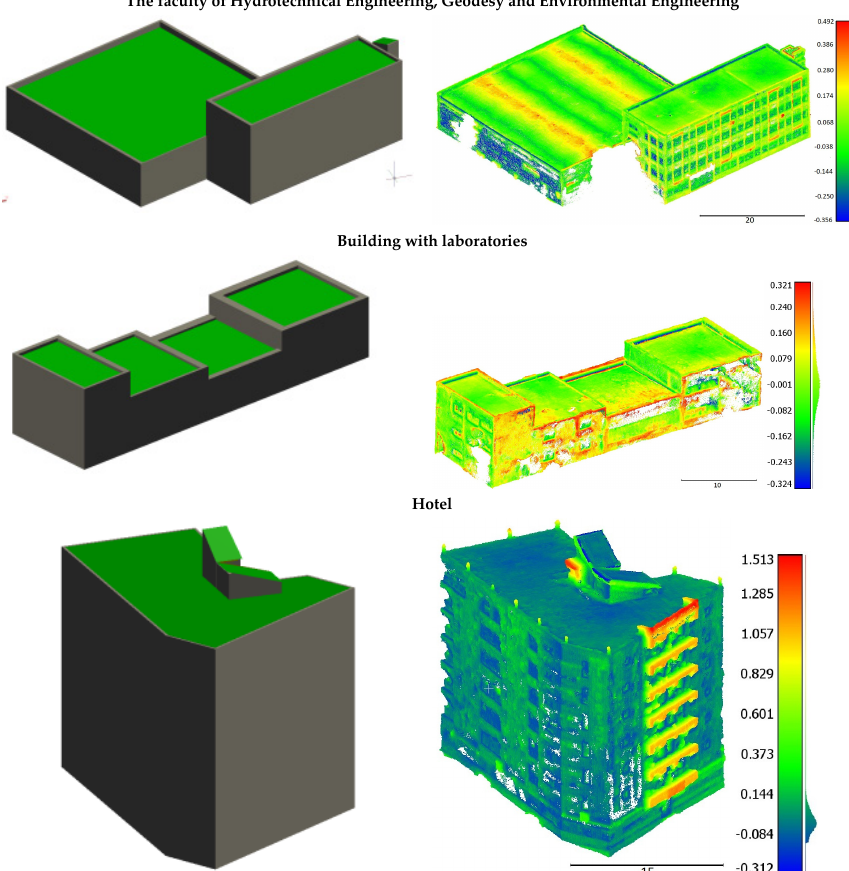
Figure A2. The errors of UAS point clouds corresponding to three analyzed buildings.